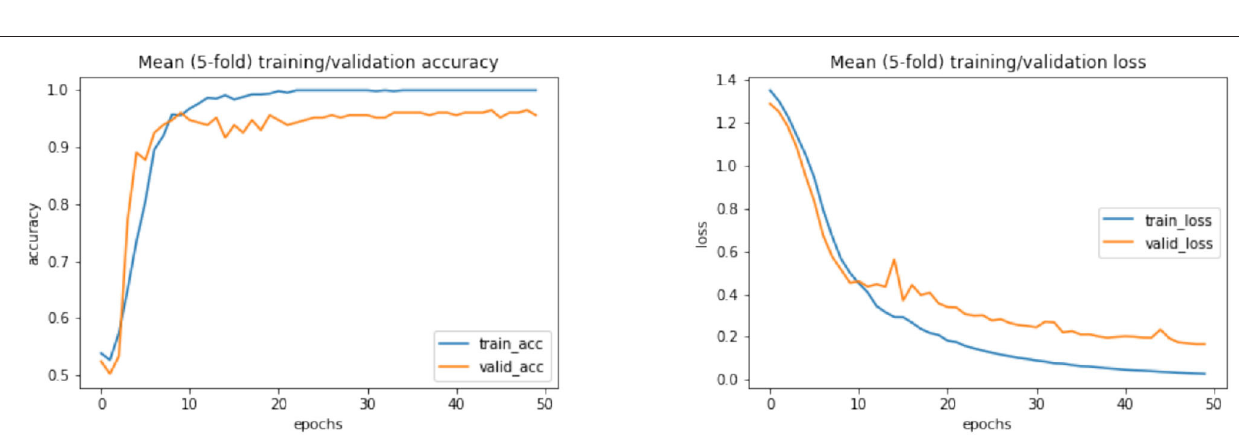
Frontiers in Neuroinformatics |